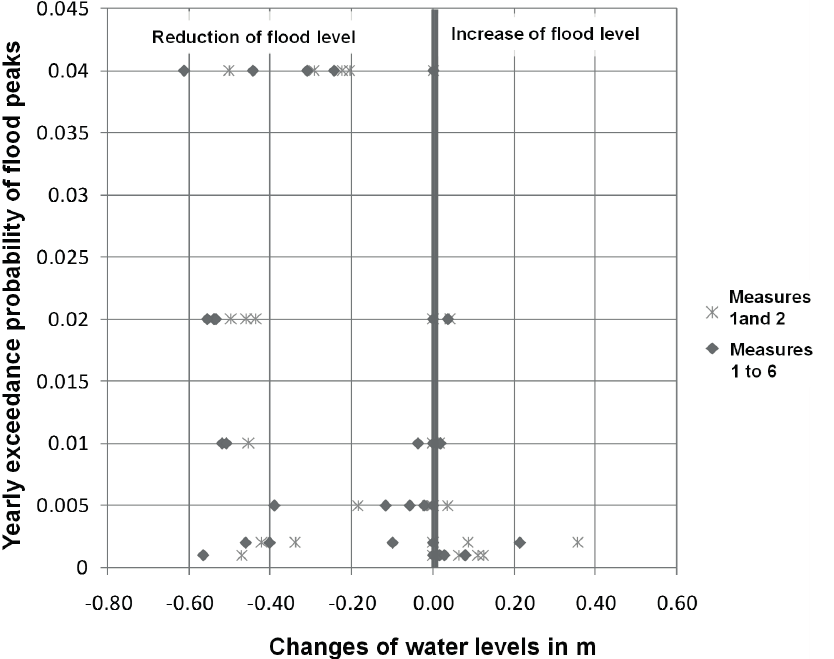
Fig. 4 Changes of flood levels at the basin outlet by two different combinations of measures. For measures 1 and 2 the existing polders are reconstructed; the combined measures 1 to 6 involve four new polders. It can be seen that additional polders reduce the flood peaks up to a 50 years flood, but would not result in significant improvements of flood protection for higher return